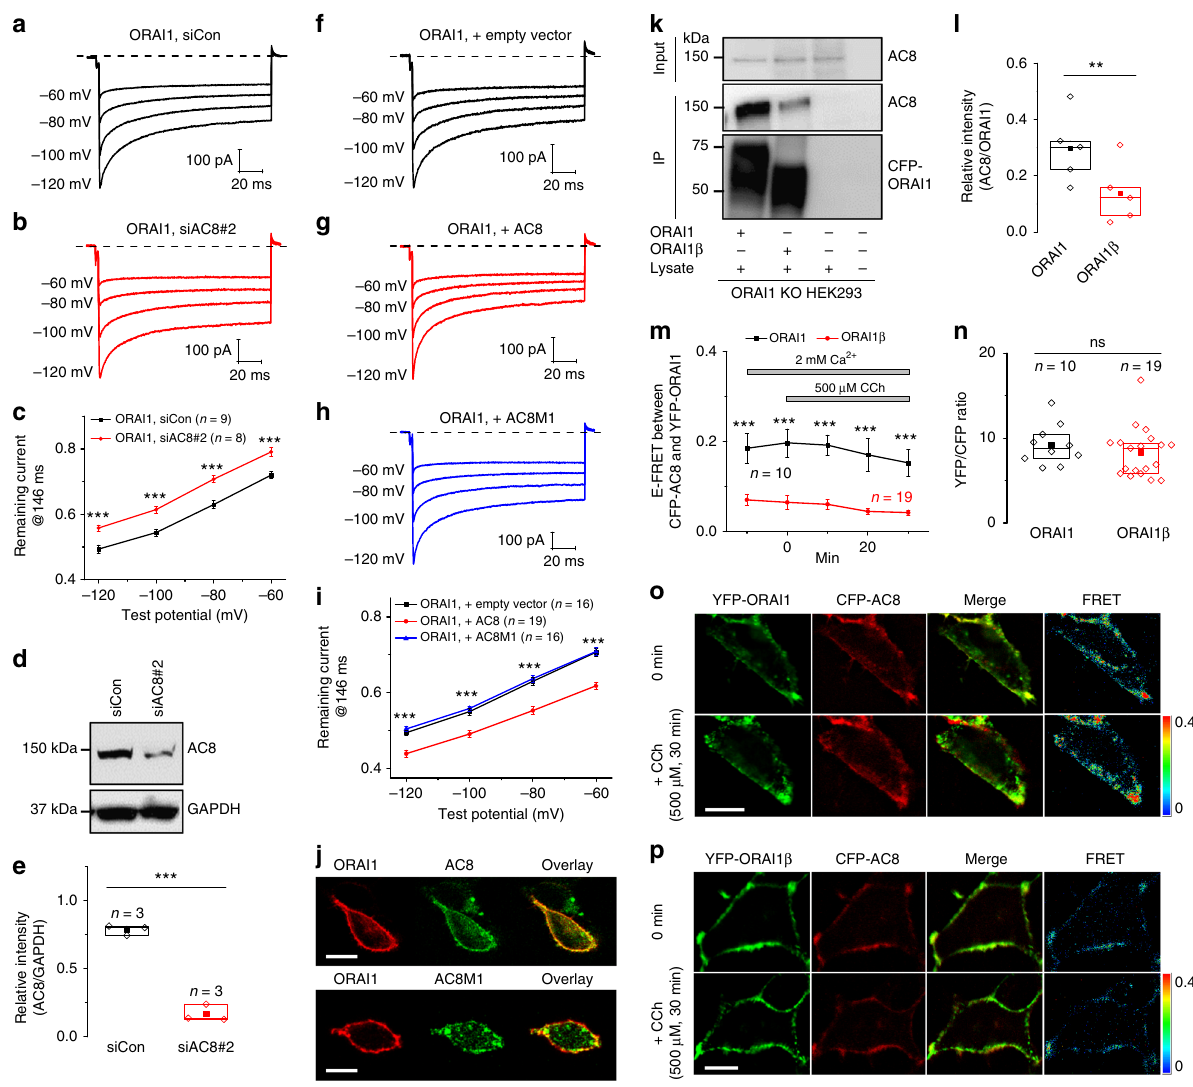
Fig. 2 AC8 mediates ORAI1 CDI through physical interaction with ORAI1. a – c Representative currents from ORAI1-KO cells co-expressing eYFP-STIM1 with ORAI1-CFP and co-transfected with a control non-targeting siRNA or b siRNA against AC8. c The extent of ORAI1 CDI from ( a ) and ( b ) represented as current remaining at 146 ms. Each data point represents mean ± SEM. d Western blot of AC8 in cells transfected with control non-targeting siRNA and AC8 siRNA. e Densitometry of AC8/GAPDH proteins from three independent experiments and shown as boxplots representing the 25th to 75th percentile range, mean, and median. f – i Representative currents from ORAI1-KO cells co-expressing eYFP-STIM1 with ORAI1-CFP and co-transfected with f an empty vector control, g AC8 cDNA, or h AC8M1 cDNA. i The extent of ORAI1 CDI from ( f ), ( g ), and ( h ) represented as current remaining at 146 ms. Each data point represents mean ± SEM. j Fluorescence image of ORAI1-KO cells co-expressing ORAI1-CFP (red) and eYFP-tagged versions (green) of either AC8 (top) or AC8M1 (bottom). Scale bar: 10 µ m ( k , l ). k Pull-down assay of AC8 with ORAI1-CFP and ORAI1 β -CFP expressed in ORAI1-KO cells. l Quanti fi cation of AC8 pull-down data from fi ve independent experiments and represented as boxplots showing the 25th to 75th percentile range, mean, and median. m e-FRET data of interactions between CFP-AC8 and either eYFP- ORAI1 or eYFP-ORAI1 β before and after addition of carbachol (Cch, 500 µ M) with each point representing mean ± SEM. n YFP/CFP fl uorescence ratios from recordings in ( m ) represented as boxplots showing the 25th to 75th percentile range, mean, and median. o , p Representative fl uorescence and FRET images of cells expressing o CFP-AC8 and eYFP- ORAI1, or p CFP-AC8 and eYFP-ORAI1 β